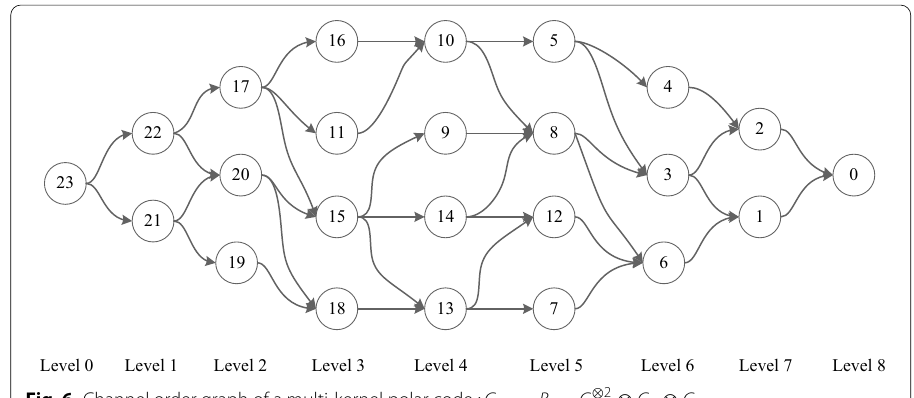
Fig. 6 Channel order graph of a multi-kernel polar code : G 24